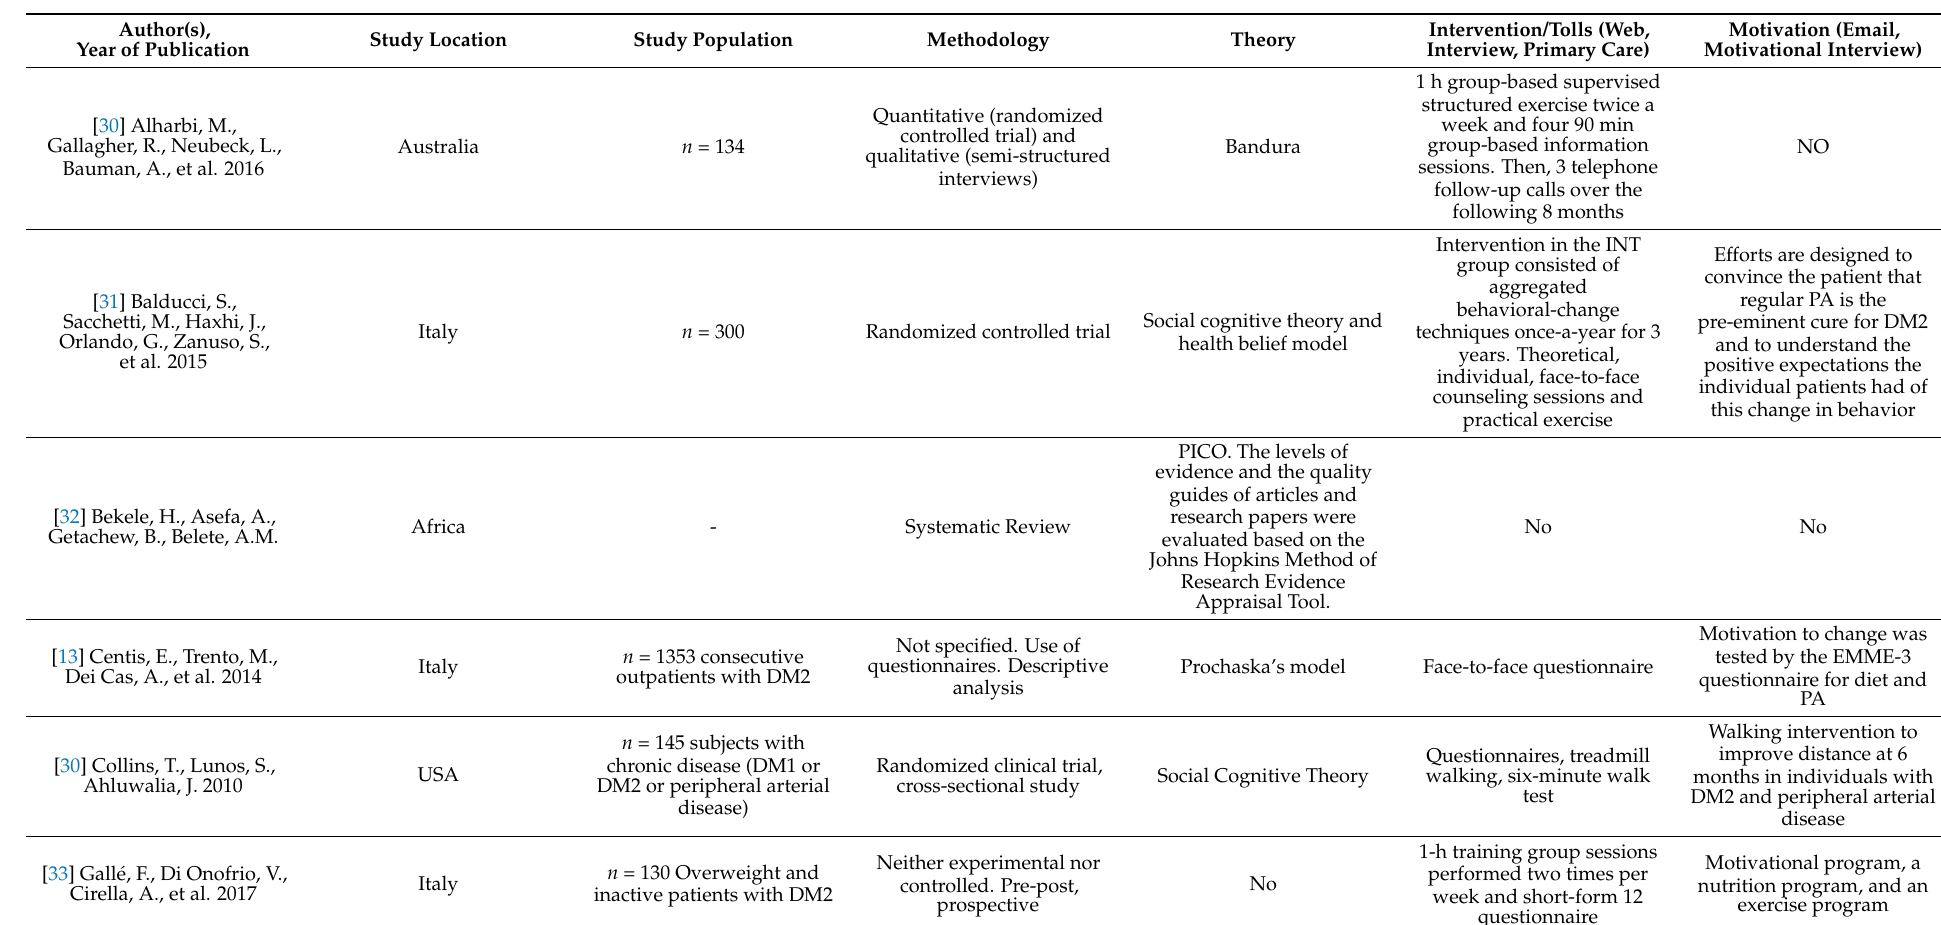
Table 2. Characteristics of the studies’ design: quantitative, qualitative, and